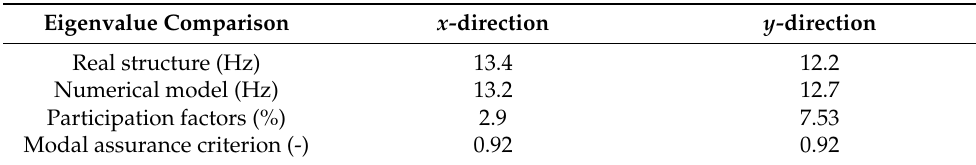
Table 4. Eigenvalue comparison of Matsumoto storehouse.